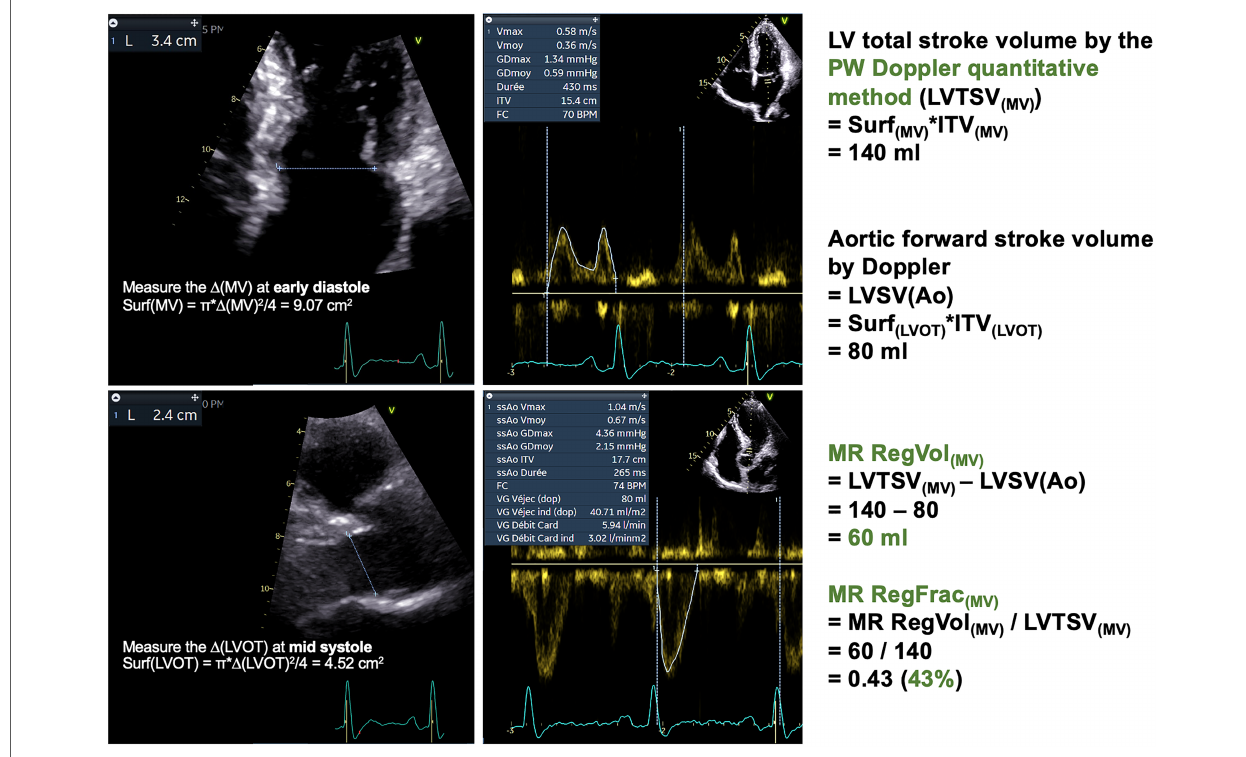
FIGURE 7 PW Doppler quantitative method. Same patient as Figure 5 . The LV total stroke volume is computed by the Doppler method as follows: LVTSV (MV) = π x ( Δ MV )2 x VTI MV /4. Importantly, the Δ MV must be measured at early diastole. Also the sample volume must be positioned at the level of the mitral annulus (not that of the lea fl et tips). The aortic systolic forward stroke volume is computed by the Doppler method as follows: LVSV(Ao) = π x ( Δ LVOT )2 x VTI (LVOT) /4. The Δ LVOT must be measured at mid systole. The MR RegVol (MV) is computed as the difference between the LVTSV (MV) and the LVSV(Ao). Consequently, the MR RegFrac (MV) is obtained by dividing the MR RegVol (MV) by the LVTSV (MV) . Δ , diameter; LV, left ventricular/ventricle; LVOT, LV out fl ow tract; LVSV(Ao), LV systolic aortic forward stroke volume by Doppler method; LVTSV( MV ), LV total stroke volume by the PW Doppler quantitative method; MR, mitral regurgitation; RegVol, regurgitant volume; RegFrac, regurgitant fraction; PW, Pulsed-Wave; VTI, velocity-time